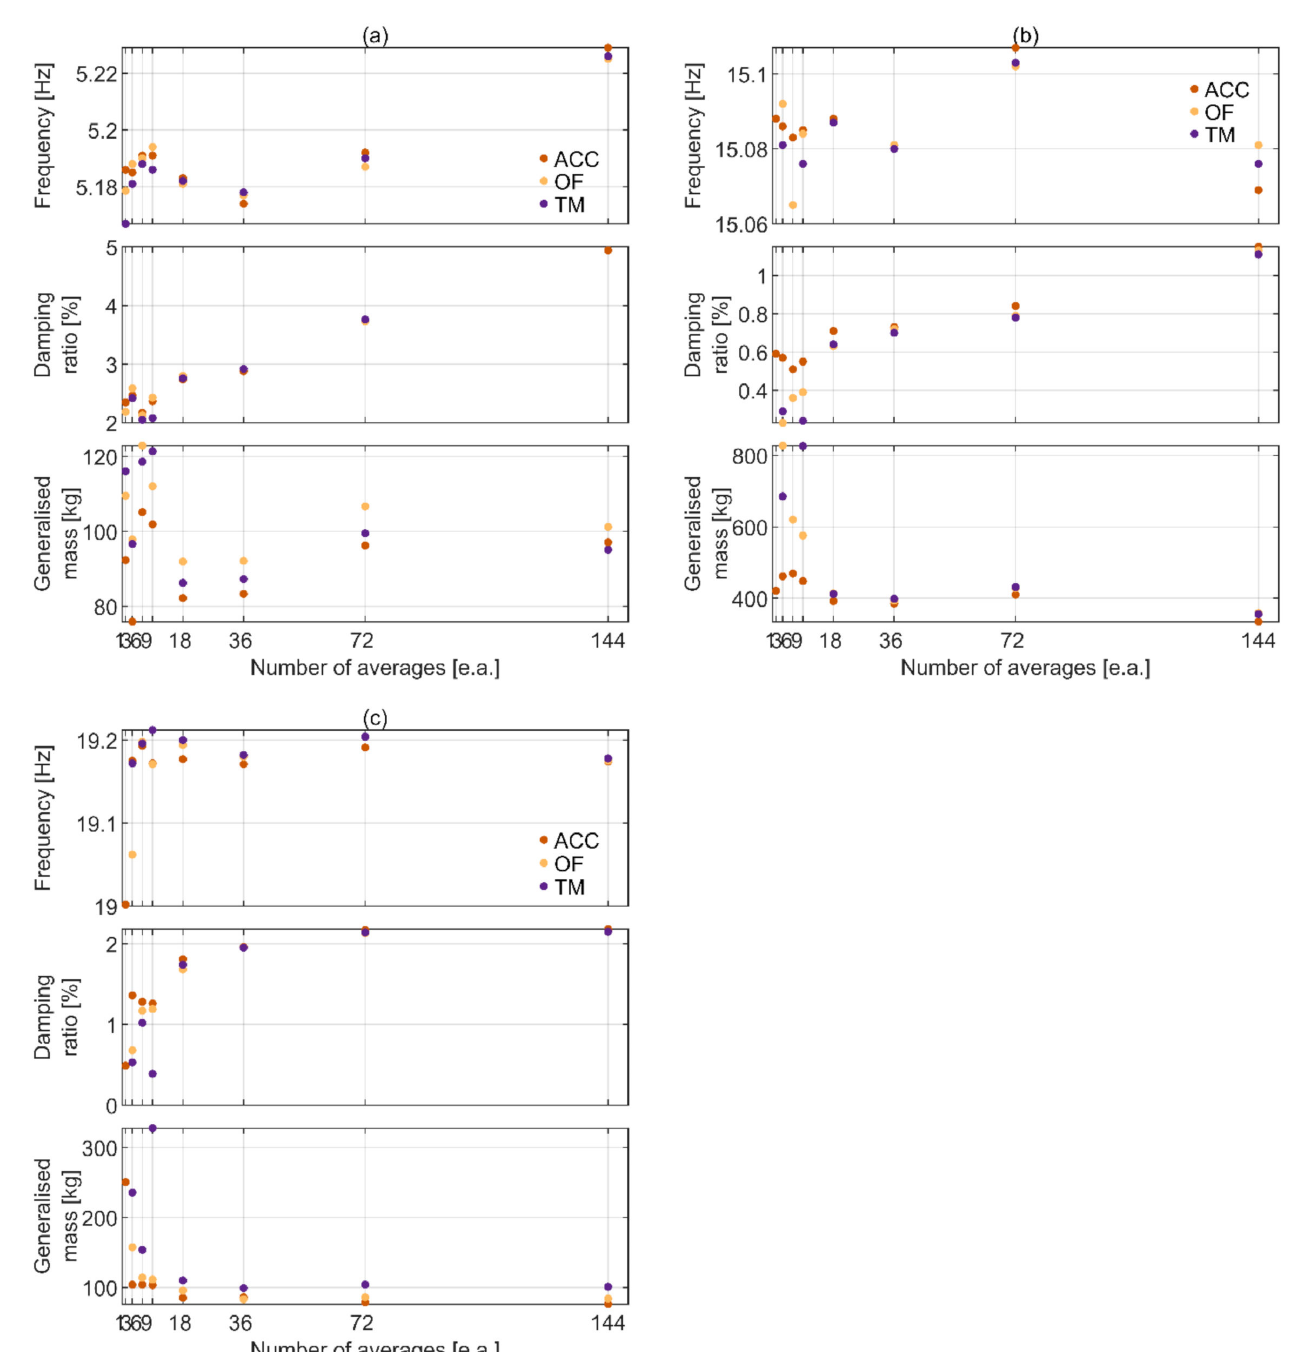
Figure 11. Exemplar stabilisation plots for modal parameters derived for ( a ) mode 1, ( b ) mode 3 and ( c ) mode 4 from